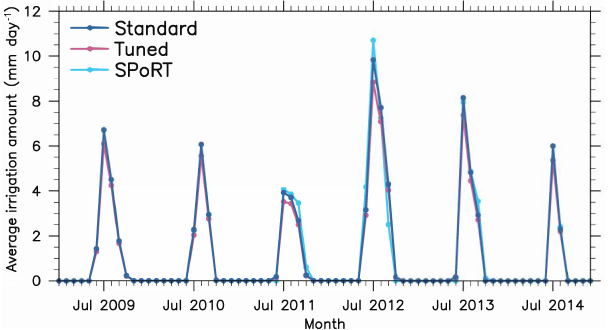
Figure 3. Domain and monthly averaged irrigation amount for each irrigation